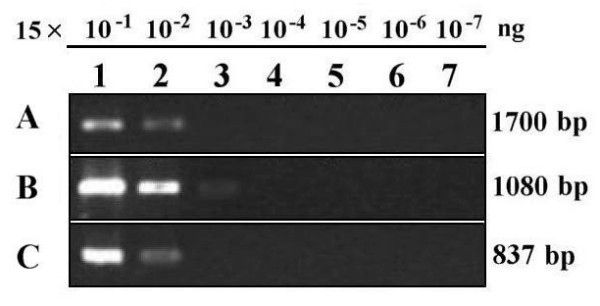
Comparison of detection sensitivity between single-step PCR assays. A, universal primers NS1/8; B, specific primers NS.Grem3/4; C, specific primers NS.Grem5/6. A 10-fold dilution series of G. abietina was used as the template.